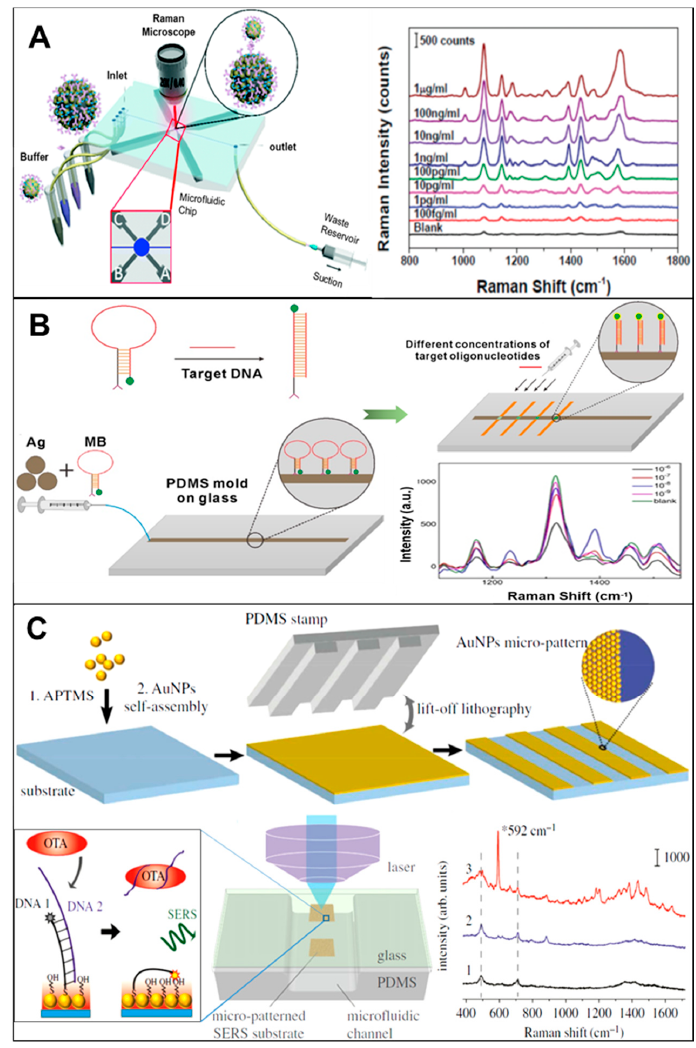
Figure 3. ( A ) Schematic illustration of the SERS-based immunoassay in a microfluidic chip for